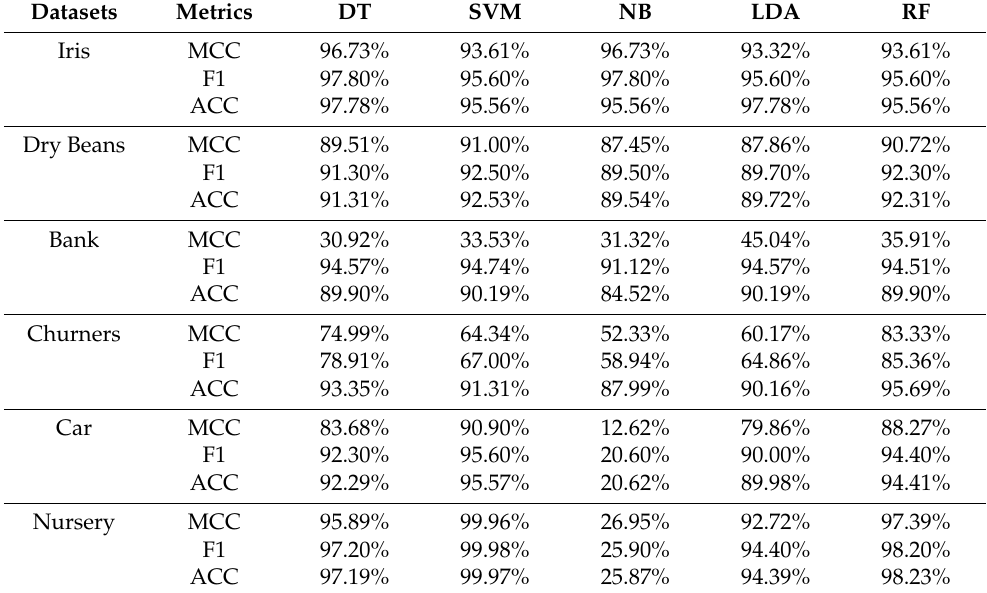
Table 2. The baseline performance of the classifiers evaluated by three